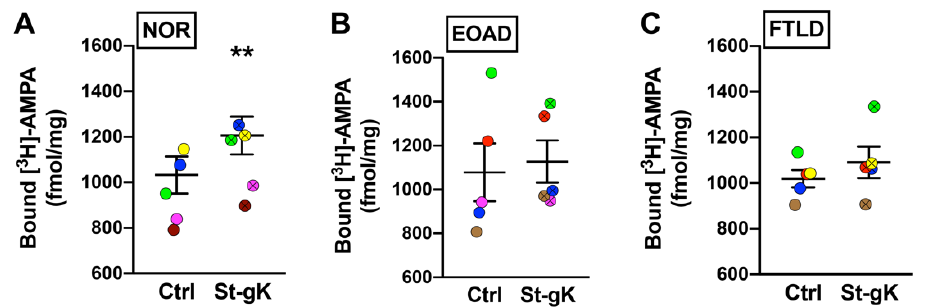
Figure 4. Chemically induced long-term potentiation (cLTP) is deficient in human cortical synap- tosomes from patients with neurodegeneration. Surface AMPAR levels in cortical synaptosomes obtained from the normal (NOR), early-onset Alzheimer’s disease (EOAD) and frontotemporal lobar degeneration (FTLD) cases were assessed following glycine priming and KCl stimulation (St-gK). A robust cLTP was induced by St-gK relative to non-stimulation control (Ctrl) in synaptosomes from the normal cases ( A ), but not the EOAD ( B ) or FTLD ( C ) cases. Results are expressed as mean ( ± SEM) bound [ 3 H]-AMPA ( n = 5 for each experiment). ** represents a statistical significance at p < 0.01. The respective stimulated and unstimulated synaptosome pairs are color coded in each panel.